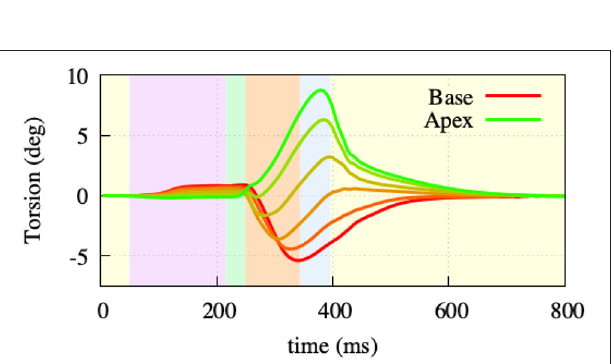
FIGURE 6 | Resulting traces of the circulatory system. (A) Pressure over time; (B) Volume over time; (C) Pressure volume diagram of the ventricles; (D) Pressure volume diagram of the atria. Left ventricle (solid red), aorta (dashed red), right ventricle (solid blue), pulmonary artery (dashed blue), right atrium (green) and left atrium (yellow). Background color in (A,B) depicting the different phases of the cardiac cycle: atrial contraction (light-purple), isovolumetric contraction (light-green), ejection (light-orange), isovolumetric relaxation (light-blue), relaxation (light-yellow).